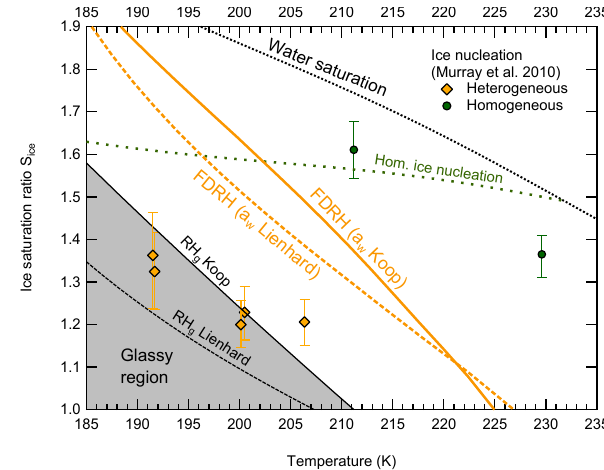
Figure B2. Comparison between calculation results of citric acid aerosol deliquescence (orange lines) and experimental ice nucle- ation data from Murray et al. (2010) (orange diamonds, green cir- cles). In the numerical simulations, 150nm diameter aerosol par- ticles are humidified at a rate of 12% RHmin − 1 , corresponding to a cooling rate of around 1–2Kmin − 1 typical of cloud cham- ber experiments. Black lines and shaded areas confine the region where a glass is the favoured thermodynamic state. The dashed lines were obtained using the water activity parameterization provided by Lienhard et al. (2012), whereas the solid lines were obtained with the parameterization in Koop et al.